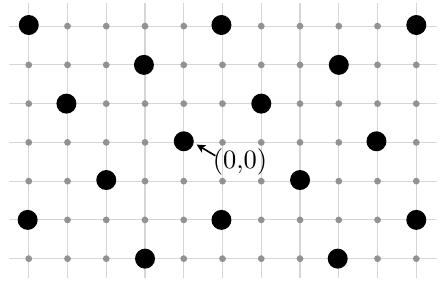
Figure 10: A perfect dominating set on the infinite